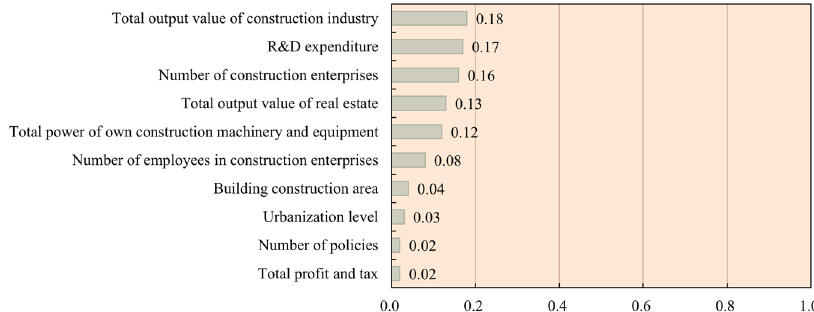
Fig. 5 The importance of factors in fl uencing construction enterprises ’ adoption of green development behaviors to the target variable. The total output value of the construction industry, R&D expenditure, number of construction enterprises, total output value of real estate, total power of machinery and equipment, number of employees in construction enterprises, building construction area, urbanization level, number of policies, and total pro fi t and tax of construction enterprises have an impact on the number of patents.